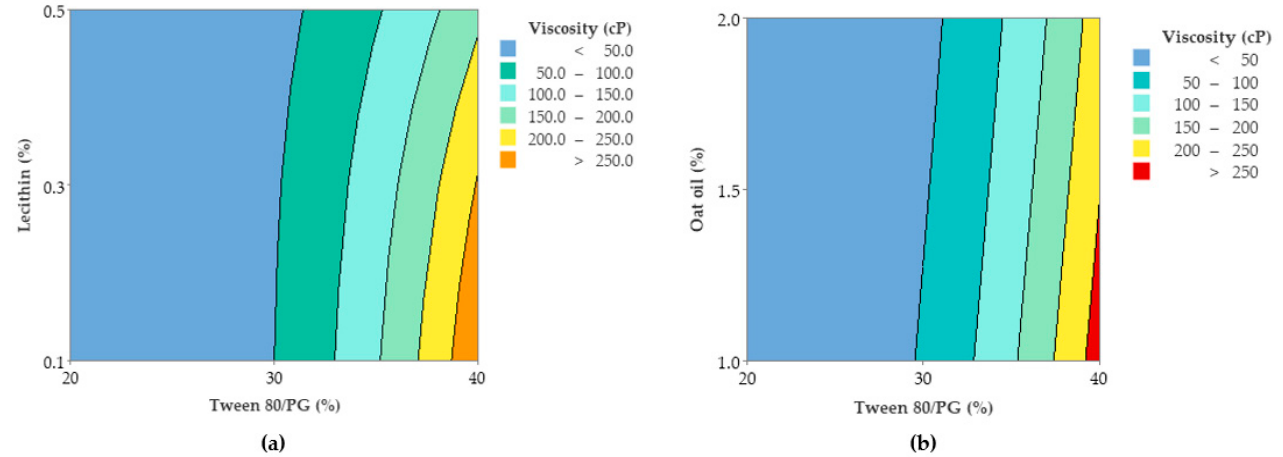
Figure 12. Contour plots representing viscosity response (Y 1 ) as function of ( a ) Tween 80/PG (%), Lecithin (%), and ( b ) Tween 80 (%), Oat oil (%).